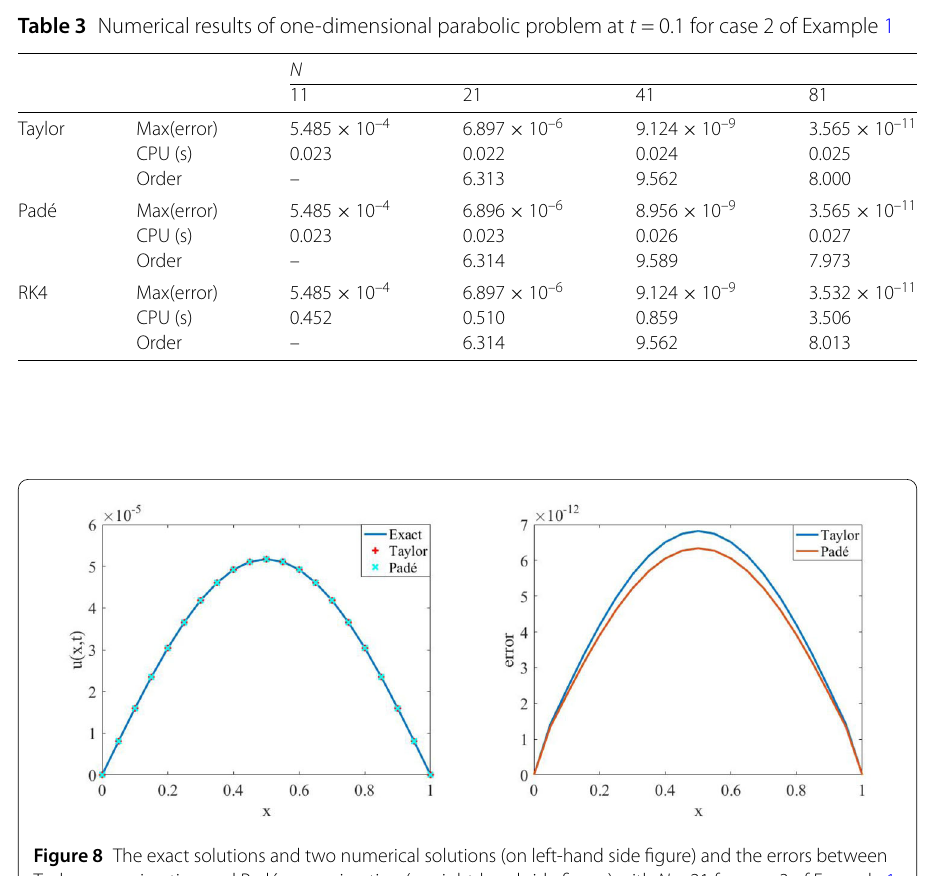
order CFDS-PIM and the eighth-order CFDS at t = 1 with the different spatial step size. It is clearly noted that the sixth-order CFDS-PIM is able to maintain high-order accuracy and excellent computational